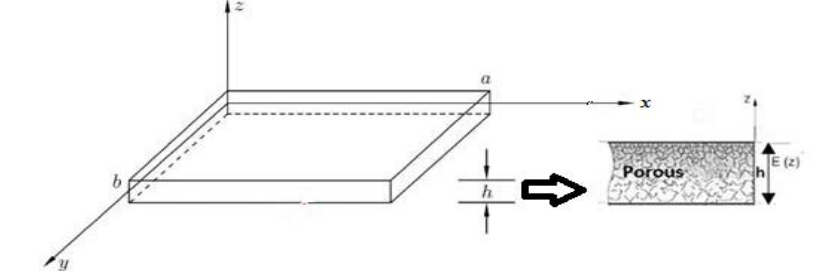
Figure 1: Geometry and FG porous plate